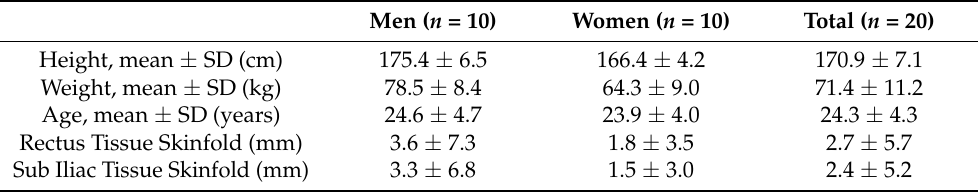
Table 1. Sample characteristics for all participants ( n = 20). Standard deviations denoted by SD. Weight is measured in kilograms (kg), height is measured in centimeters (cm), and skinfold measure- ments in